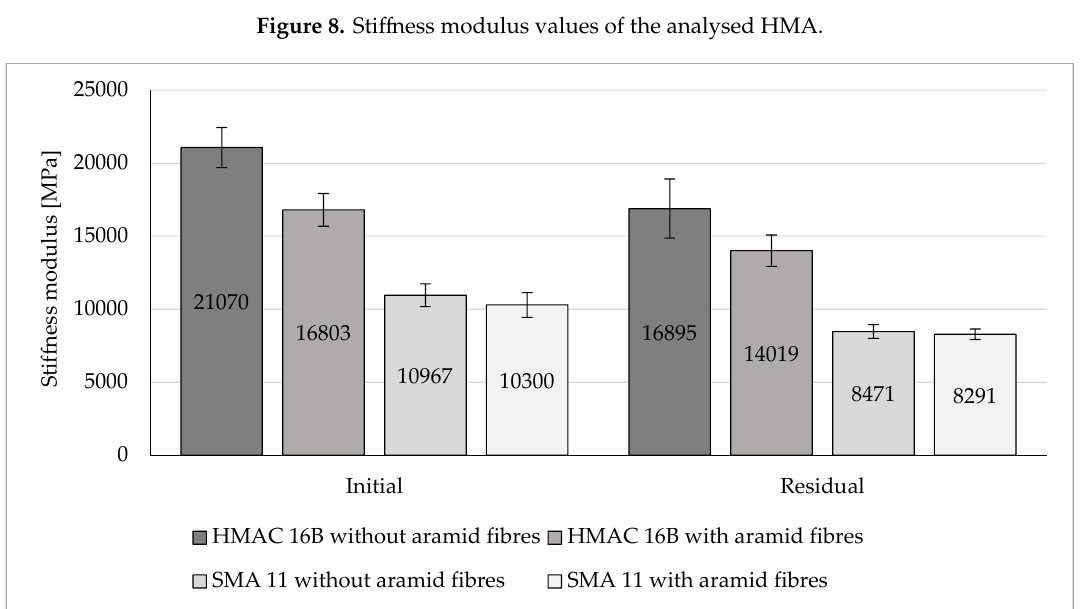
Figure 9. Initial and residual values of stiffness modulus of the analysed HMA.